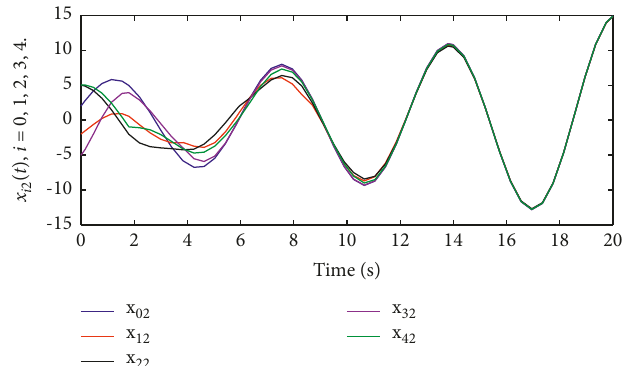
Figure 6: The state x i 2 of the multi-agent systems.